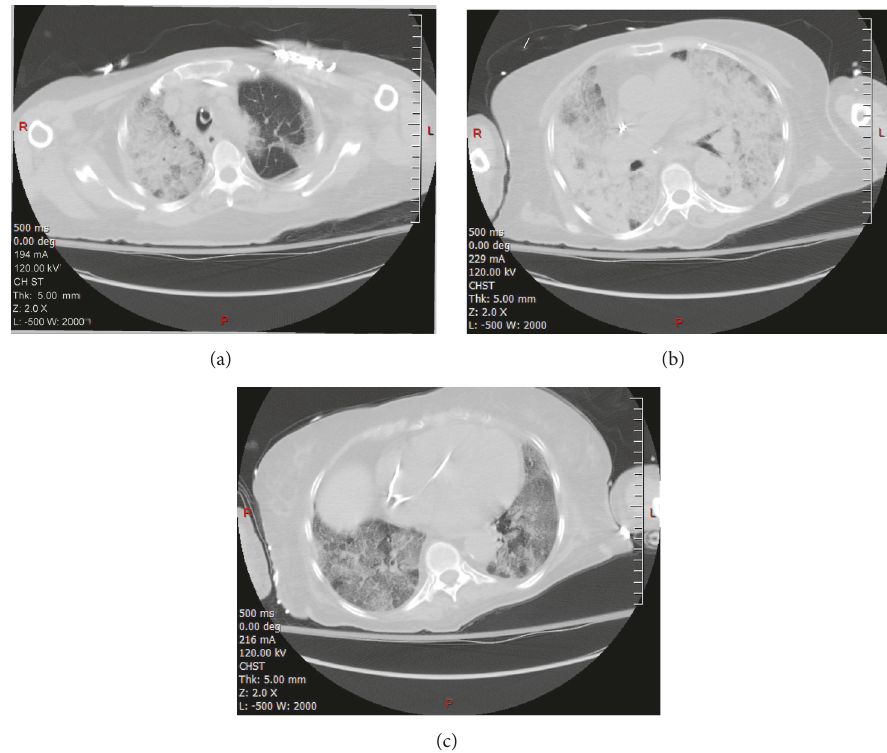
Figure 5: CT scan images above the plane, thru the plane, and below the plane of SBRT treatment showing diffuse infiltrates ((a), (b), and (c) images